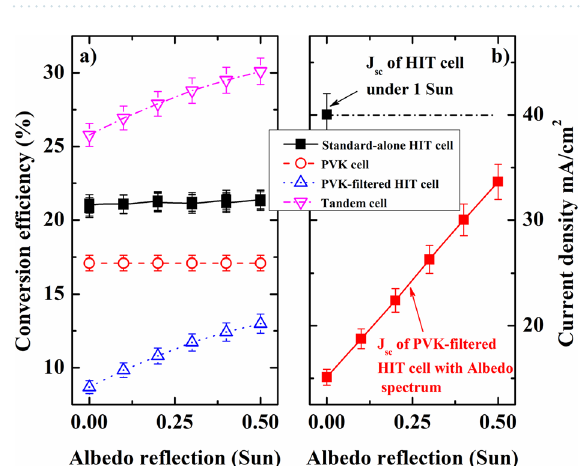
limits of the c-Si HJ solar cell of approximately 42 mA/cm 2 can be achieved using albedo reflection for the bifacial four-terminal tandem cell. To achieve higher conversion efficiency, further investigations such as lesser plasma damage of underlying organic–inorganic layers 21 or higher albedo light intensity are required. Bifacial 4‑terminal PVK/HIT tandem solar cell modeling. Simulated results were employed to exam- ine the PVK/c-Si HJ tandem solar cell to elucidate the reason for the improvement in J sc and, thereby, the con-